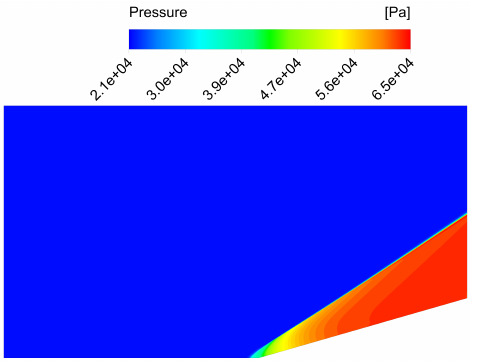
Figure 6. Pressure field for the compression corner problem with a 16 degree ramp angle.